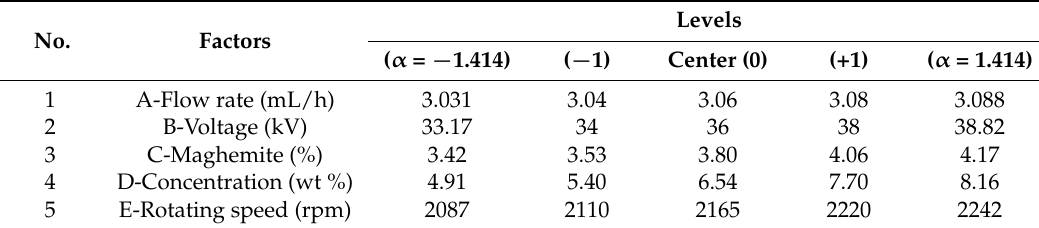
Table 4. Factors and levels for CCD